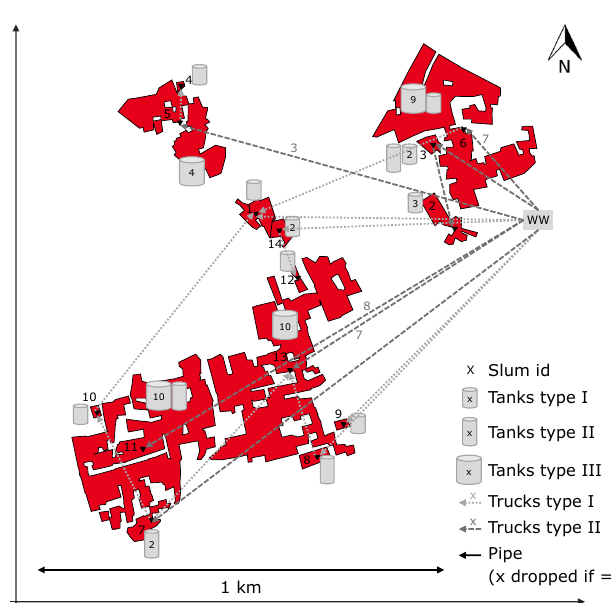
Figure 8. Optimization result for a slum cluster in Dhaka (2010), Bangladesh.